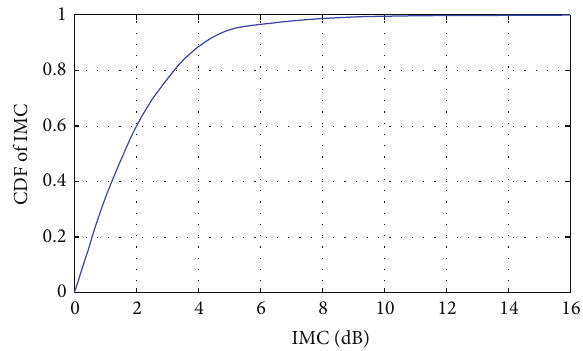
Figure 16: CDF of IMC